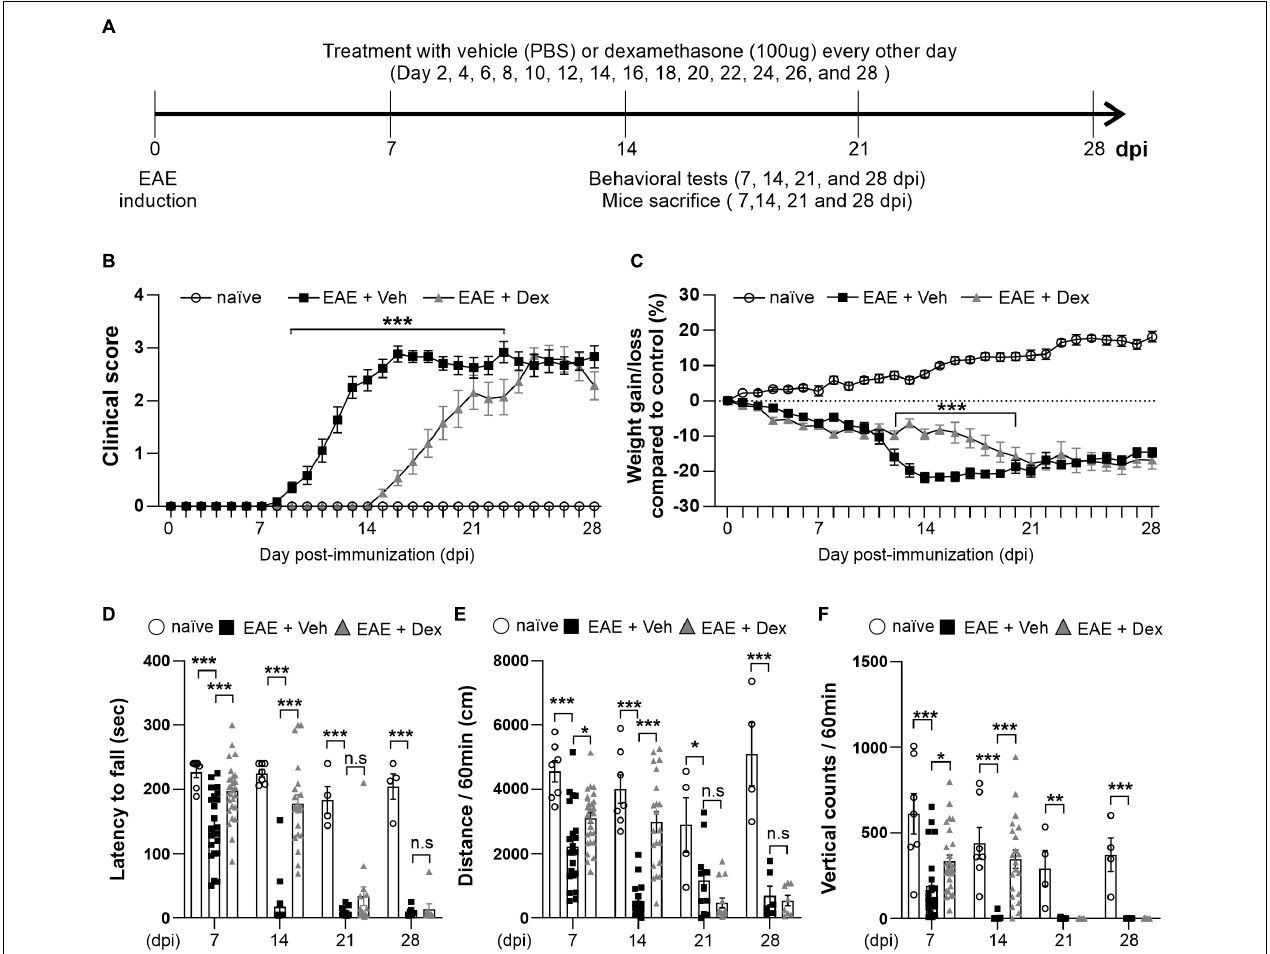
FIGURE 1 | Dexamethasone delayed the manifestation of clinical signs and reduced motor behavior dysfunction in EAE mice. (A) Diagram of the experiment design. To induce EAE, C57BL/6 were immunized with MOG 35 - 55 /CFA and Pertussis toxin (PTX). EAE mice received dexamethasone (100 µ g) or vehicle (PBS) intravenously (i.v. tail vein) every second day. Mice were transcardially perfused after behavioral experiments at an interval of 7 days. (B) Mean clinical scores for each day from immunization (0 dpi) to 28 dpi. At *** P < 0.001, treatment with dexamethasone significantly delayed the manifestation of clinical signs compared to the EAE + Veh group at 9–22 dpi. Mean ± SEM, n = 4–26. (C) Gain/loss of body weight. At *** P < 0.001, treatment with dexamethasone significantly reduced body weight loss compared to the EAE + Veh group at 12 dpi to 20 dpi. Mean ± SEM, n = 4–26. (D) Latency to fall during the Rotarod test was recorded at 7, 14, 21, and 28 dpi. (E) Distance traveled and (F) vertical counts (rearing-up) was recorded with the open-field test at 7, 14, 21, and 28 dpi. (D,E) n.s; non-significant, * P < 0.05, ** P < 0.01, and *** P < 0.001, Mean ± SEM. n = 7–27 (7 dpi), n = 7–21 (14 dpi), n = 4–14 (21 dpi), and n = 4–8 (28 dpi). (B–F) 2-way ANOVA was used followed by Tukey’s post hoc test for multiple comparisons. Data from 4 repeated